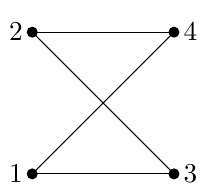
Figure 20. The kernel S ( x 1 , x 2 , x 3 , x 4 ) in pictorial